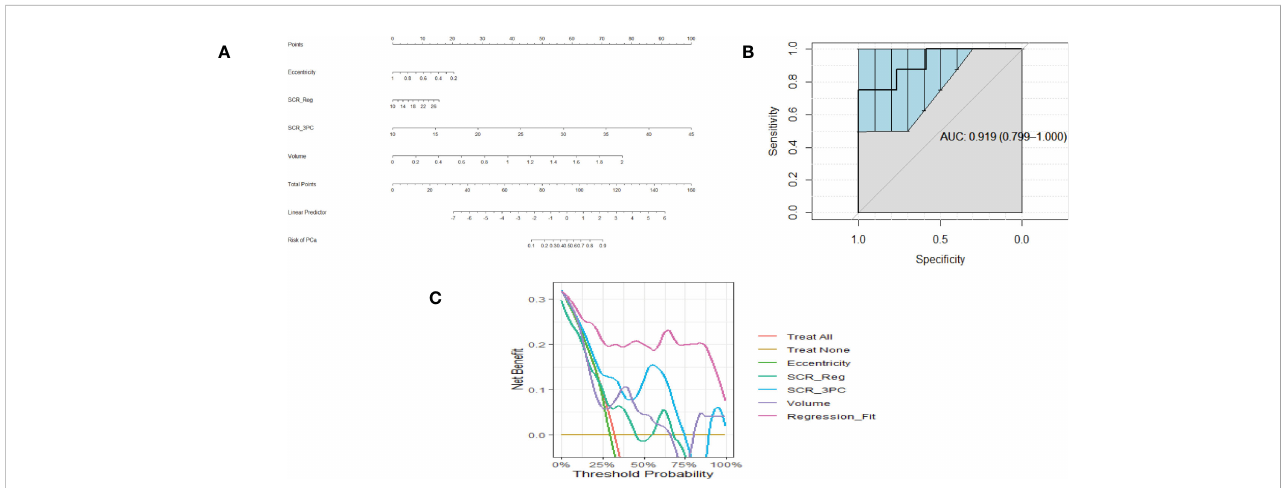
FIGURE 3 (A) is a nomogram resulting from logistic fi t to Gleason score with eccentricity, tumor volume, and SCR with 3 PC removed. (B) Receiver Operator Curve applied to Logistic Regression for eccentricity, 3 PCs removed from SCR, tumor volume. Area Under the Curve (AUC) and 95% Con fi dence Limits shown as bold and lighter line with vertical bars. (C) Decision Curve Analysis for (A) nomogram.